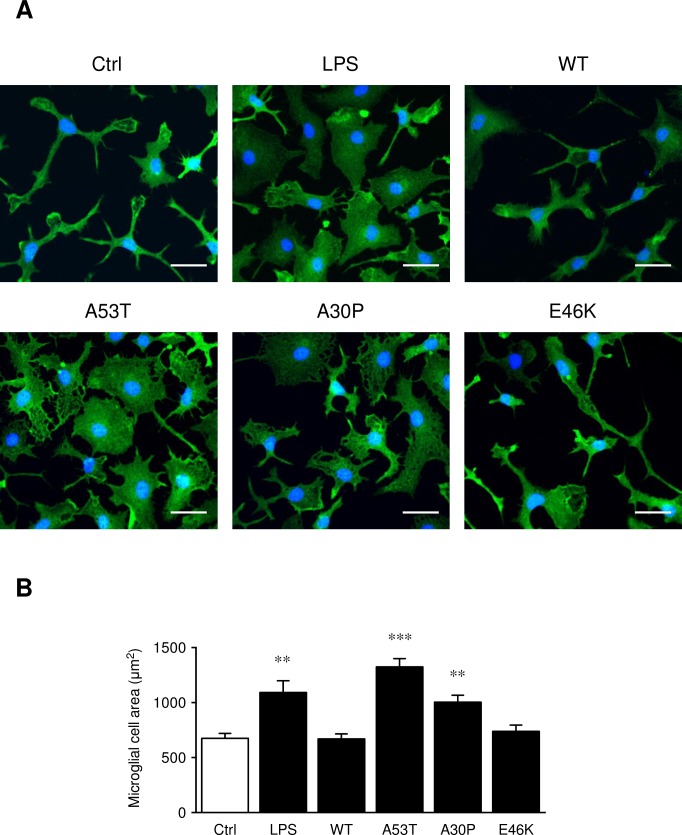
α-synuclein proteins alter differently the microglial cell morphology.Primary microglial cells were treated for 6 h with the pro-inflammatory compound LPS (positive control, 1 ng/ml), as well as with 5 μM of the wild-type α-synuclein (WT) and the 3 mutants (A53T, A30P, E46K) preparations (Fig 2A). Cells were labeled with the microglial marker Iba1 (green) and counterstained with nuclear stain DAPI (blue). Scale bar: 25 μm. After these treatments, microglial cell area (μm2) was measured (Fig 2B) with the open source image-processing package Fiji® software. Data represent mean ± SEM of 20 measures per condition. ** p < 0.01, *** p < 0.001, significantly different from control condition.